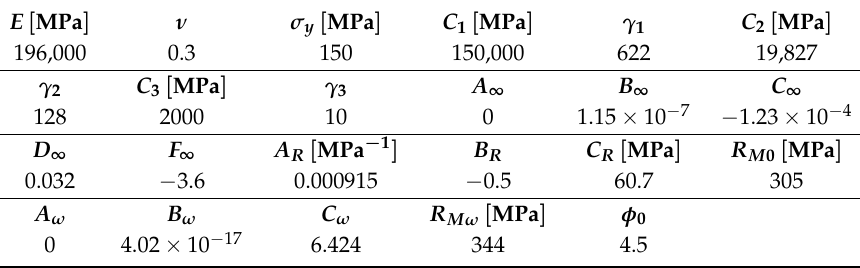
Table 1. Material parameters of the proposed model for SS304.